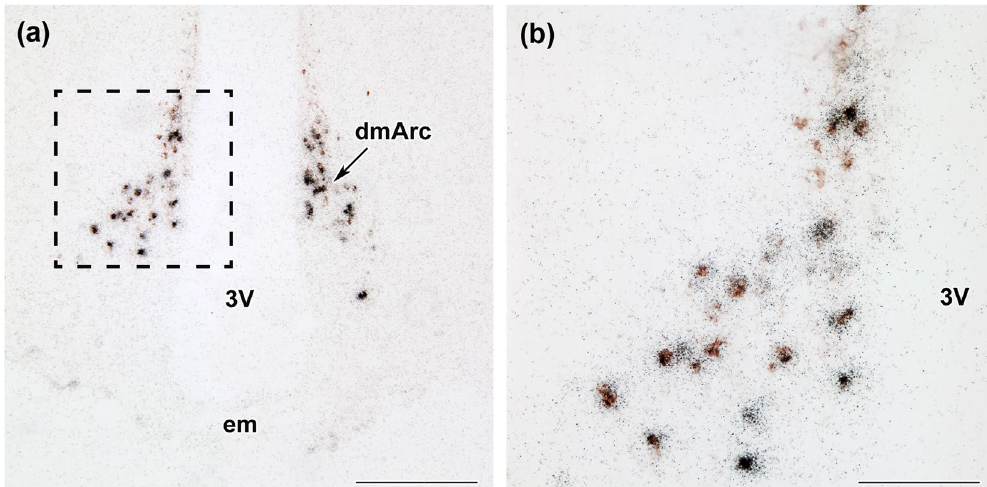
Figure 4. IGFBP-3 expression co-localizes with tyrosine-hydroxylase (TH) in the arcuate nucleus. The combination of IGFBP-3 in situ hybridization histochemistry (black dots) and TH immunohistochemistry (brown cells) shows that TH-positive cells in the dorsomedial subdivision of the arcuate nucleus express IGFBP-3 mRNA in lactating rat dams. Abbreviations include 3 V – third ventricle, dmArc – dorsomedial arcuate nuclei, em – median eminence. Scale bar = 400 µ m for A, and 100 µ m for B.